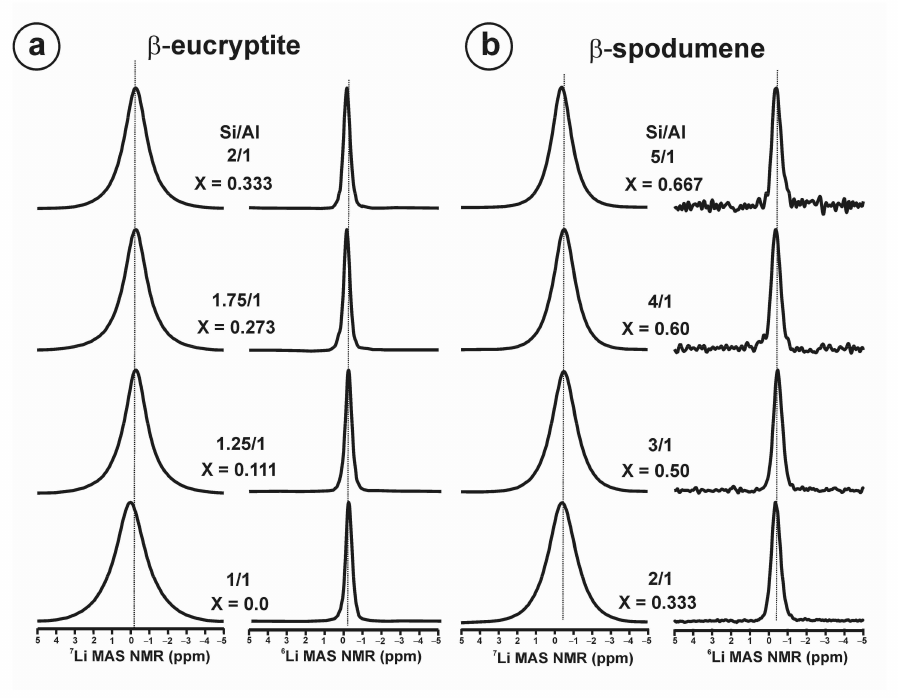
Figure 8. The 7 Li (left column) and 6 Li (right column) MAS NMR spectra of β -eucryptite ( a ), and β -spodumene ( b ), for several x values in Li 1 − x Al 1 − x Si 1+x O 4 along the solid solutions. Table 5. Deconvolution of the 7 Li MAS NMR spectra of β -eucryptite and β -spodumene selected